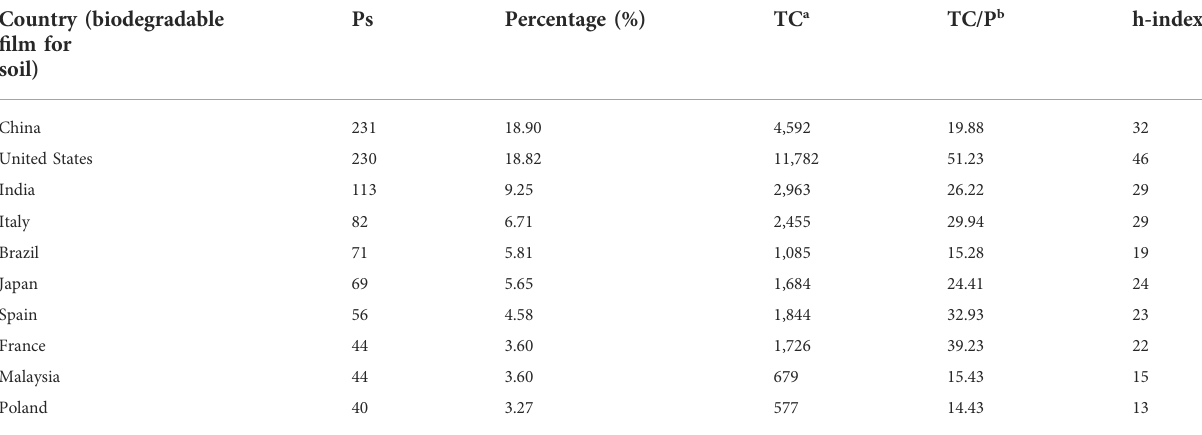
TABLE 2 Top ten most productive countries in terms of relevant articles. Country (biodegradable fi lm for